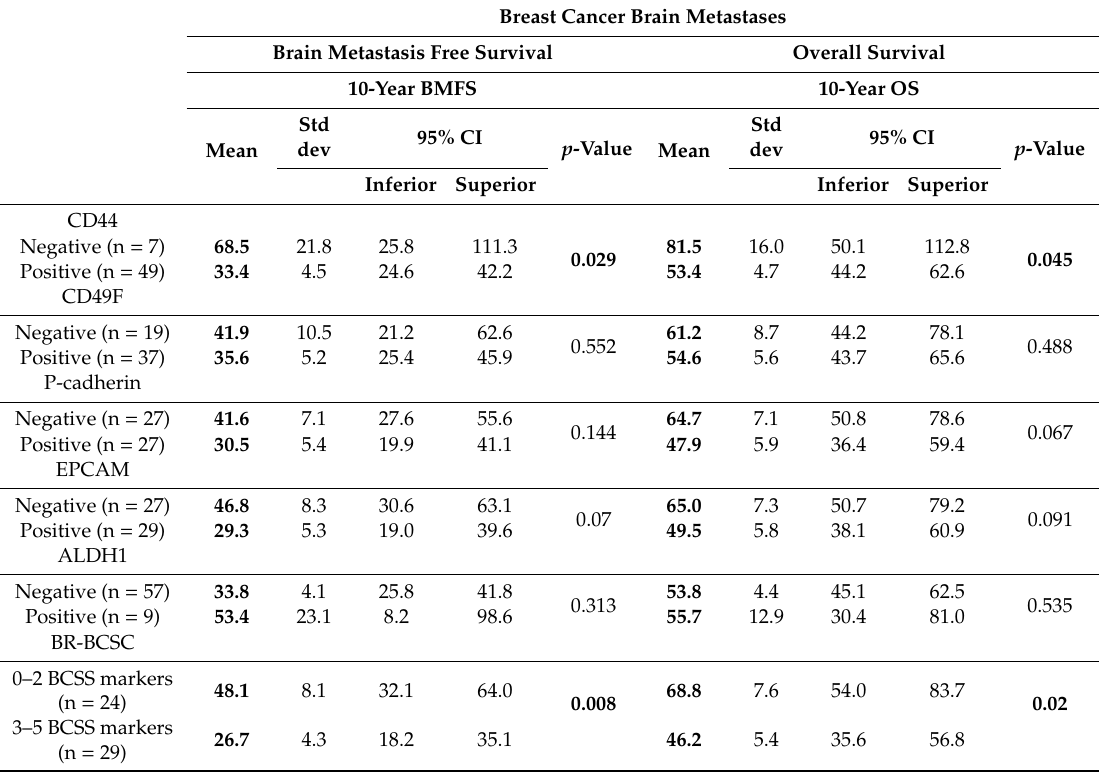
Table 2. Survival for the individual breast cancer stem cell (BCSC) markers CD44, CD49f, P-cadherin, EPCAM, and ALDH1 and for the brain (BR) BCSC (BR-BCSC) signature. Survival means were estimated using the Kaplan–Meier method and compared using the log-rank (Mantel–Cox) test. A significant level of 5% was considered. Missing cases were not considered for statistical analysis. Mean survival are in bold as well as the significant p